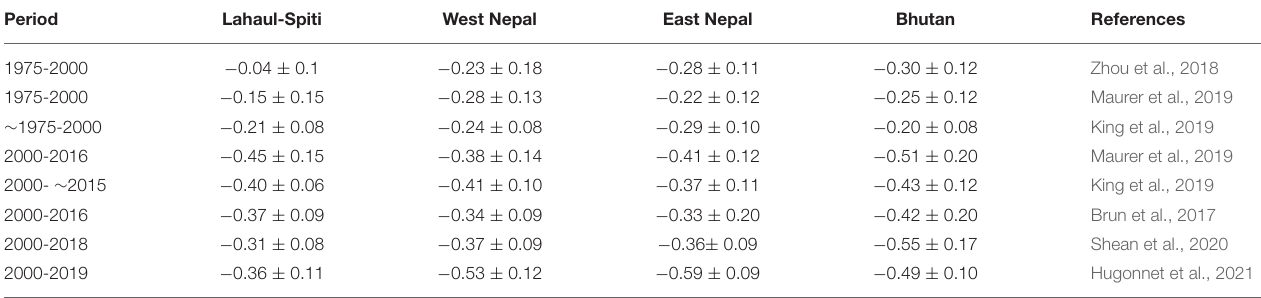
TABLE 3 | Geodetic approach-based glacier mass balance estimates (m w.e. a − 1 ) covering all of the Himalaya by various studies.